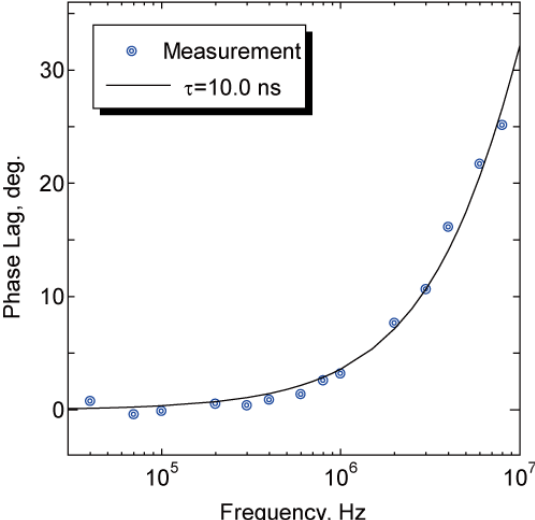
Figure 9. Phase-lag and fitting curve of Qdot655 measured by the fabricated probe. The fluorescence lifetime of Qdot655 at room temperature was calculated to be 10.0